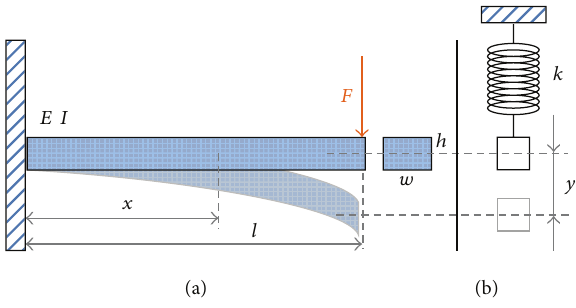
Figure 1: The solid mechanic model (a) and the simplified model (b) of the cantilever